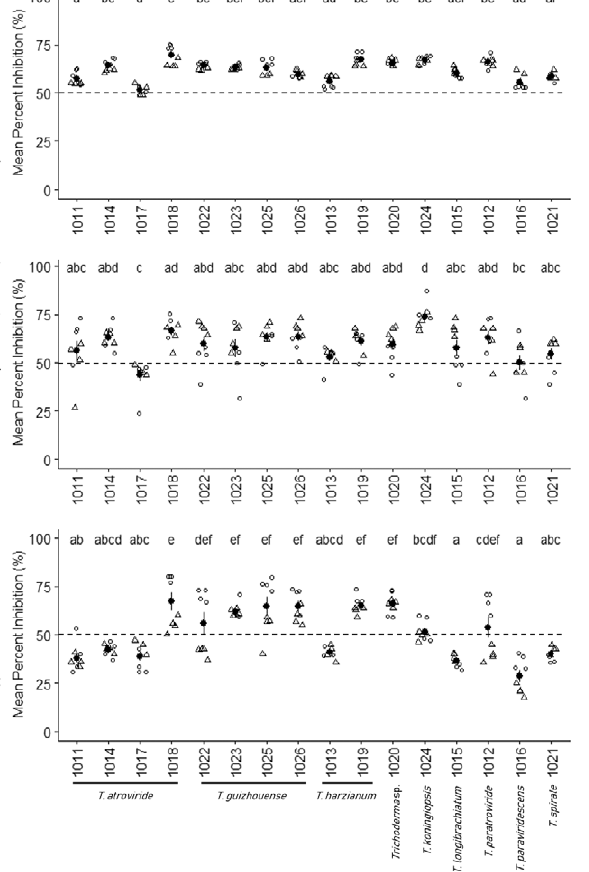
(Table 2). Trichoderma atroviride (PARC1018) and T. paratroviride (PARC1012) gave the greatest MPDC (88- 100%) against N. parvum from day one to day 21 after treatment. The remaining isolates provided much lower MPDCs (23 to 70%) against N. parvum , except for T. guizhouense (PARC1026) that gave MPDCs of 69% at 1 d after treatment, 75% at 7 d, and 83% at 21 d after treat- ment. All the isolates tested in the DCA experiment gave MPDCs greater than 50% when pruning wounds were challenged with 5,000 N. parvum spores per wound 7 d after treatment (Table 2).